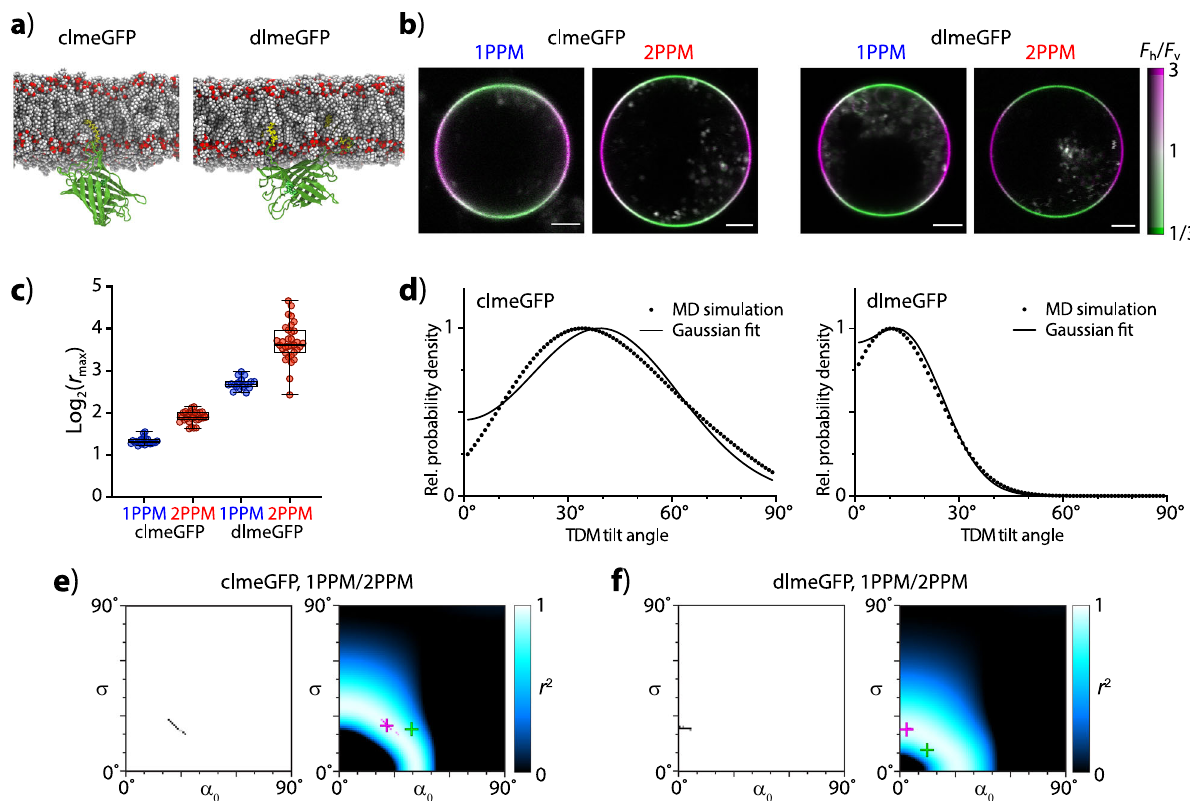
Fig. 6 Deriving quantitative information on molecular orientations from images of model fl uorescent protein constructs (clmeGFP and dlmeGFP) in round cells. a Renderings of the construct structures from MD simulations. b Images of round cells expressing clmeGFP (left) and dlmeGFP (right), obtained by 1PPM (left panels) and 2PPM (right panels). Scale bars: 10 µ m. The images are colored according to LD, as indicated by the color bar. c Values of log 2 ( r max ) derived from cells expressing clmeGFP (left) and dlmeGFP (right). Median values, 25 th and 75 th percentiles, and ranges are shown. d Distributions of TDM tilt angles derived from MD simulations (dots) and the corresponding best- fi t wrapped Gaussian distributions (curves) for clmeGFP (left) and dlmeGFP (right). e Combinations of α 0 , σ values consistent with pooled 1PPM and 2PPM observations of cells expressing clmeGFP. Left: estimate of 95% con fi dence interval obtained by bootstrapping. Right: heat map of goodness of fi t (expressed as r 2 ) of combined 1PPM/2PPM data, for a range of distributions of molecular orientations (described by values of α 0 , σ ). The α 0 , σ combination in best agreement with microscopy data is indicated by a magenta cross, with the 95% con fi dence area marked in magenta. The α 0 , σ combination obtained from MD simulations is indicated by a green cross. f Same as in ( e ), but for